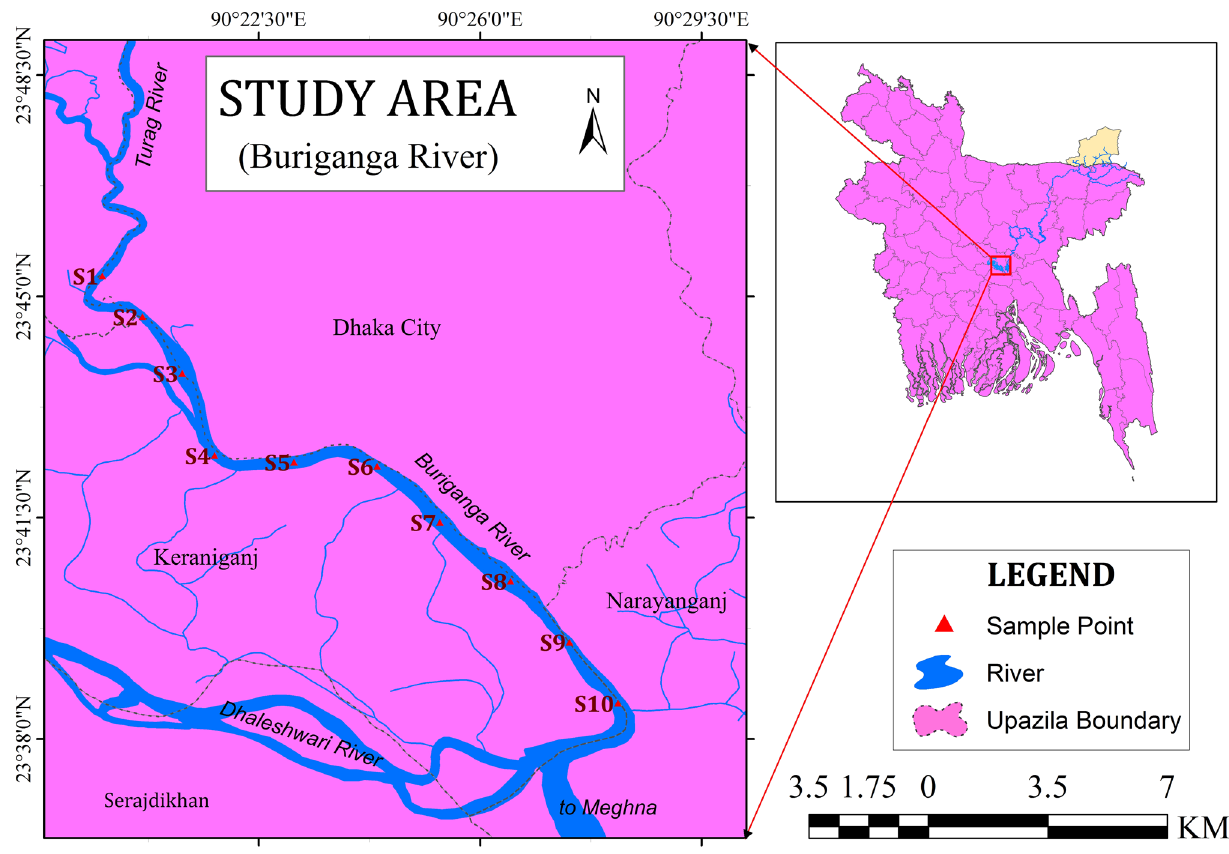
Fig. 1 The study area: River Buriganga, Dhaka,